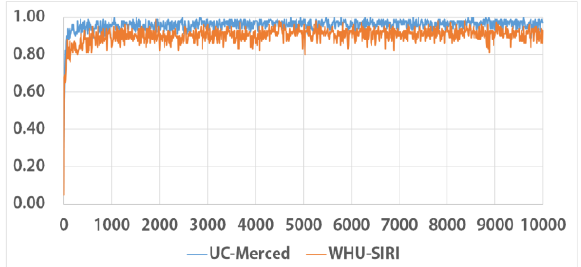
Figure 5. Testing accuracy (y-axis) vs. iteration times (x-axis) during the Google Tensorflow training process.